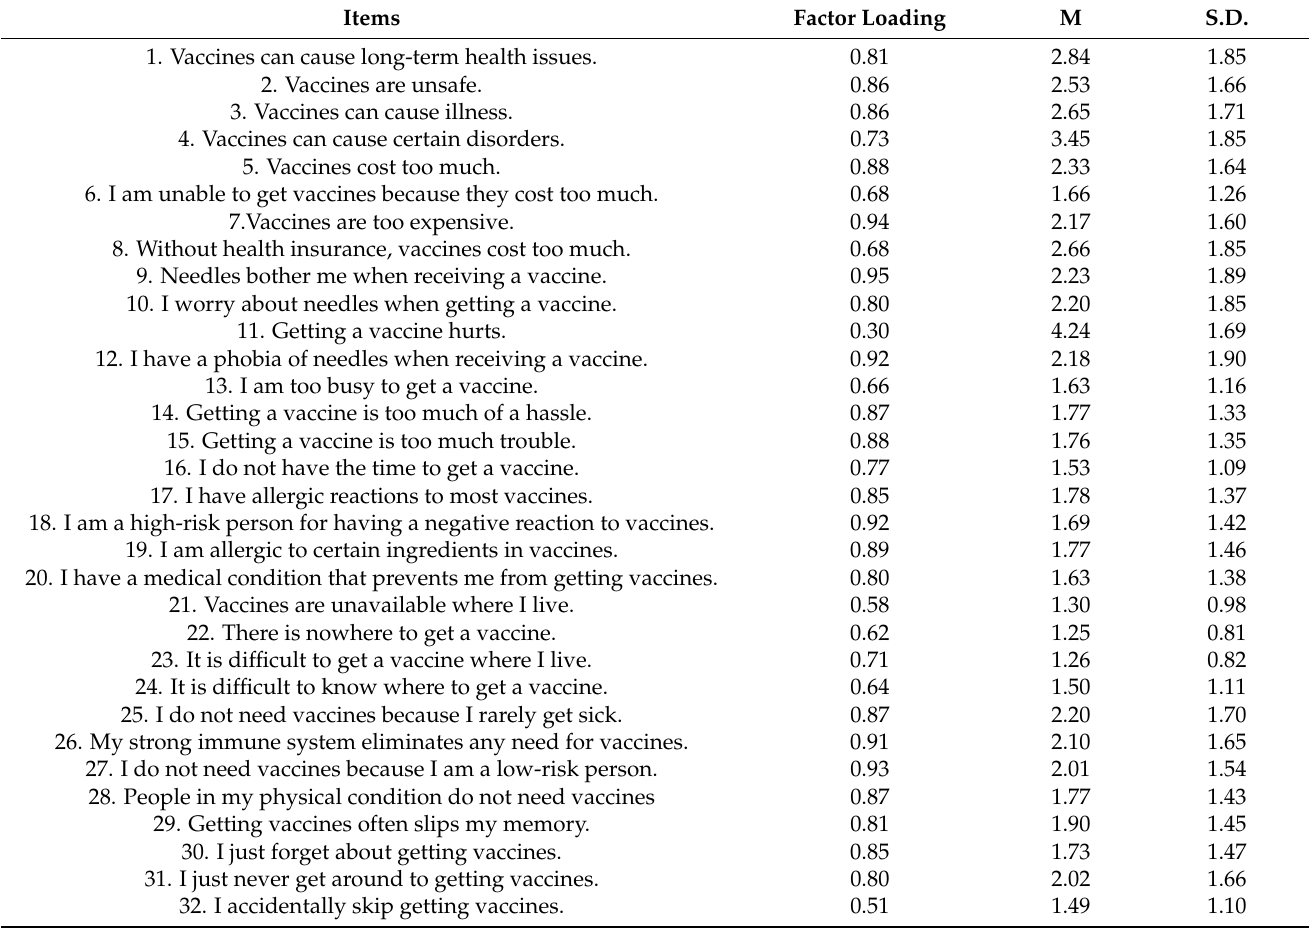
Table 3. Confirmatory factor analysis item loadings, mean and standard deviation of the items. Items